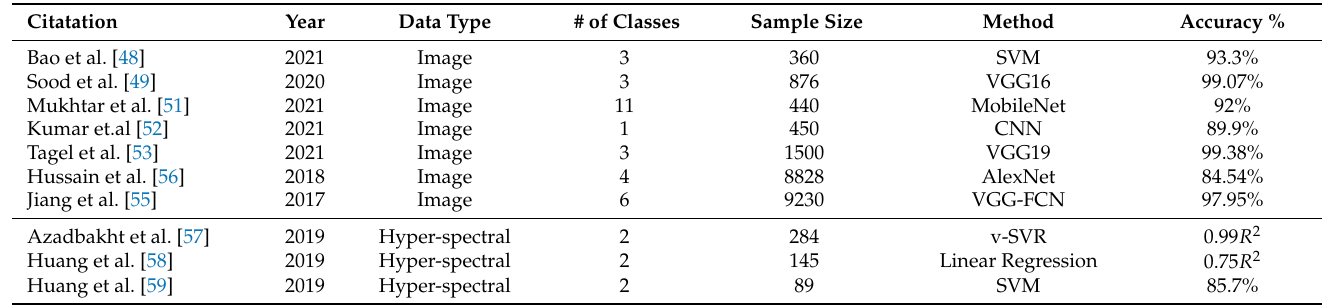
Table 11. Performance comparison of selected studies on machine learning based wheat disease detection and corresponding